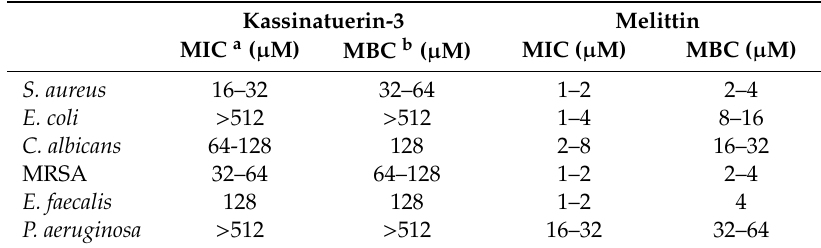
Table 2. Antimicrobial activity of kassinatuerin-3 against selected microorganisms. Melittin was used as a positive control.